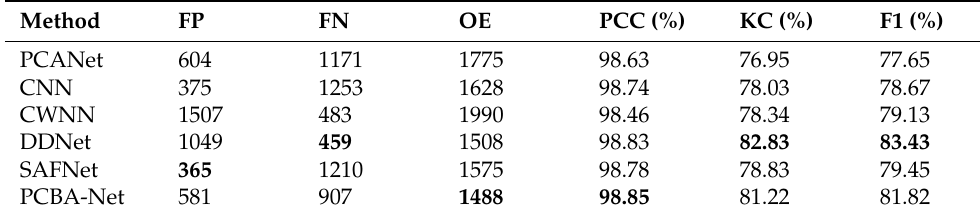
Table 6. Change detection results for Yellow River B dataset.